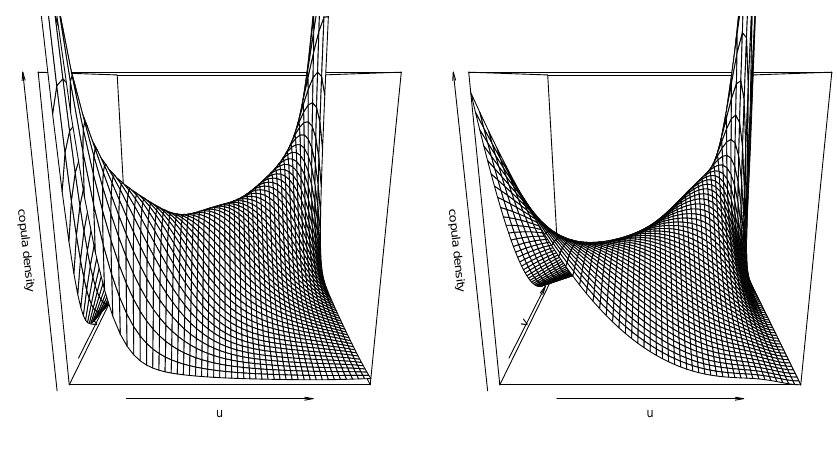
Figure 8: Scatterplot of empirical cdfs of 10-minute returns for Bitcoin and Ethereum